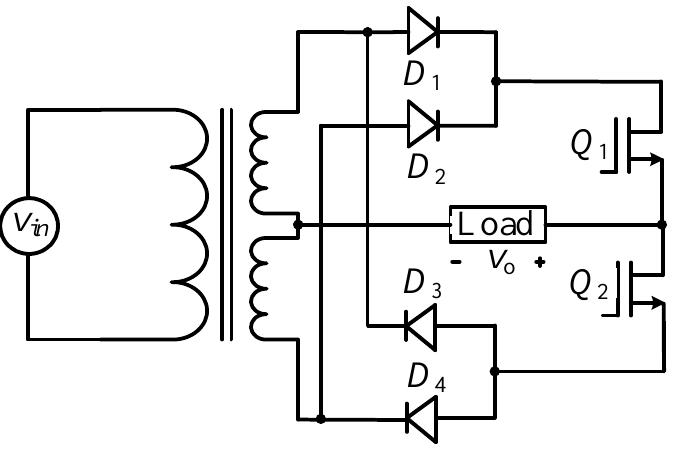
Figure 1. Compact power converter reported in